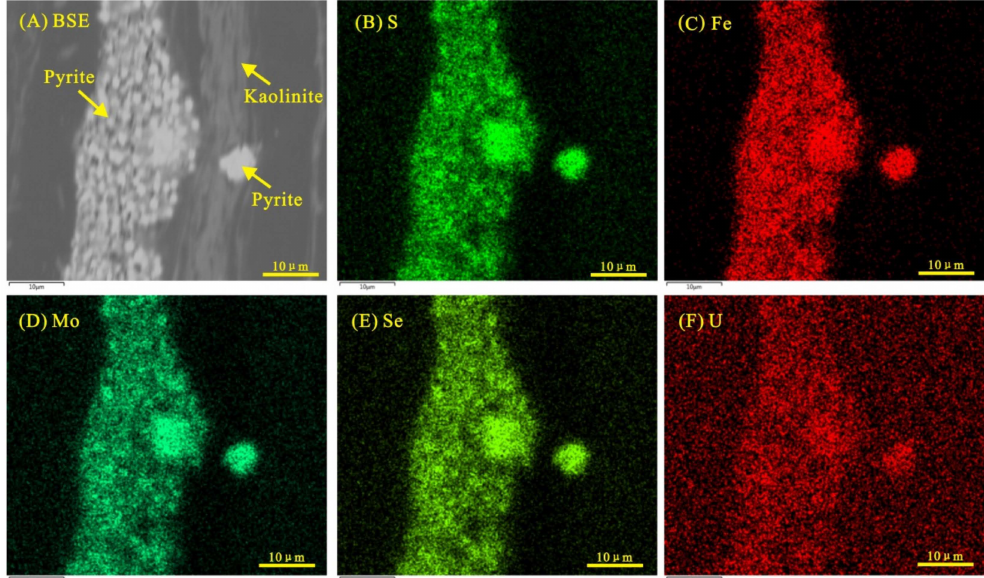
Figure 12. SEM-EDS mapping showing the distribution of S, Fe, Mo, Se, and U (sample CLB4-1). ( A ): SEM back-scattered electron images of minerals; ( B )–( F ): the distribution of S, Fe, Mo, Se, and U,